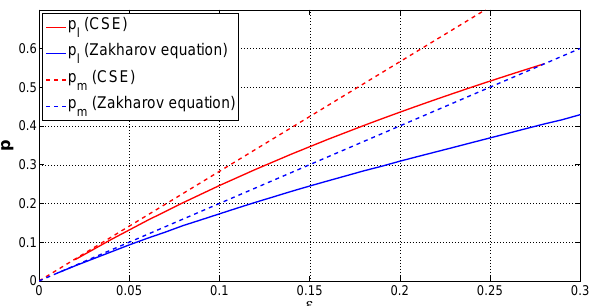
Fig. 1. The dependence of values of p corresponding to the limit of linear instability ( p ‘ ) and to the linearly most unstable distur- bance ( p m ) on the carrier wave steepness according to the NLS and Zakharov